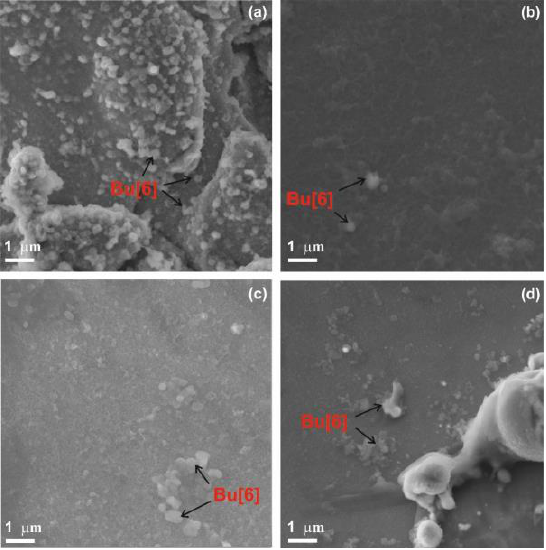
Figure 4. SEM images of the surface of porous TiNi with bambusuril deposited under vacuum ( a ); without external effects ( b ); under microwave exposure ( c ); under ultrasonic exposure ( d ).